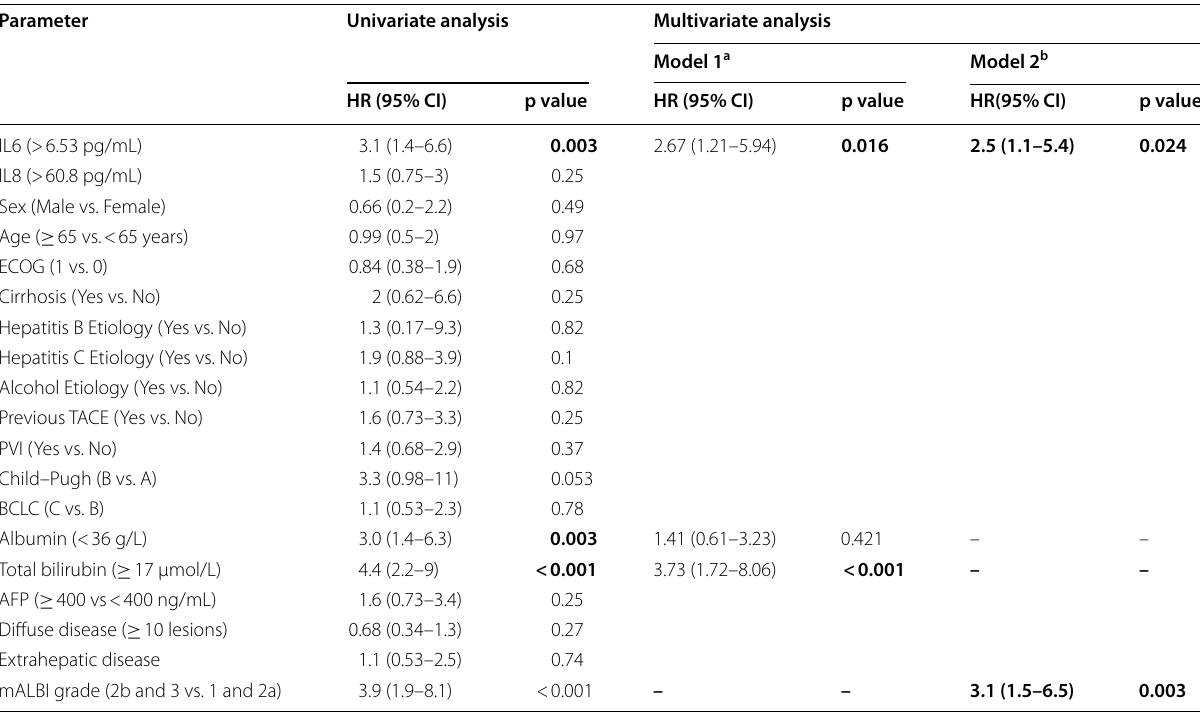
Bold type indicates statistical